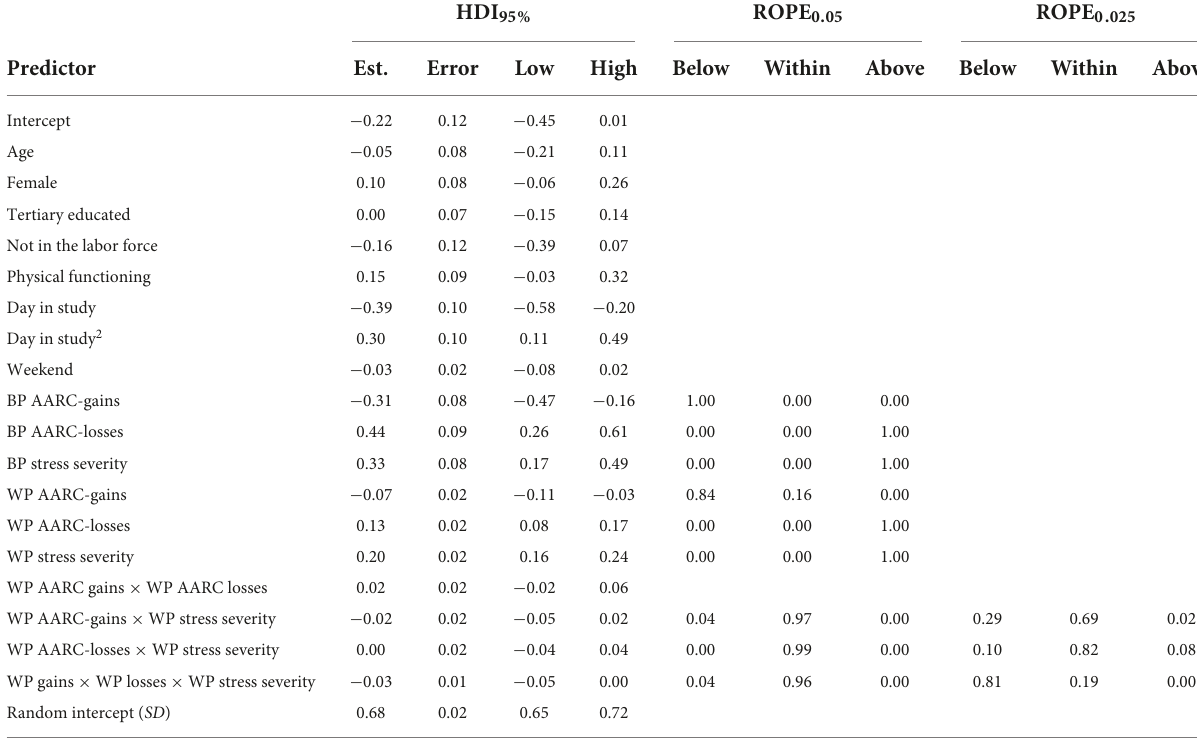
TABLE 2 Results of Bayesian hierarchical mixed model predicting negative affect. HDI 95% ROPE 0 . 05 ROPE 0 . 025 Predictor Est. Error Low High Below Within Above Below Within